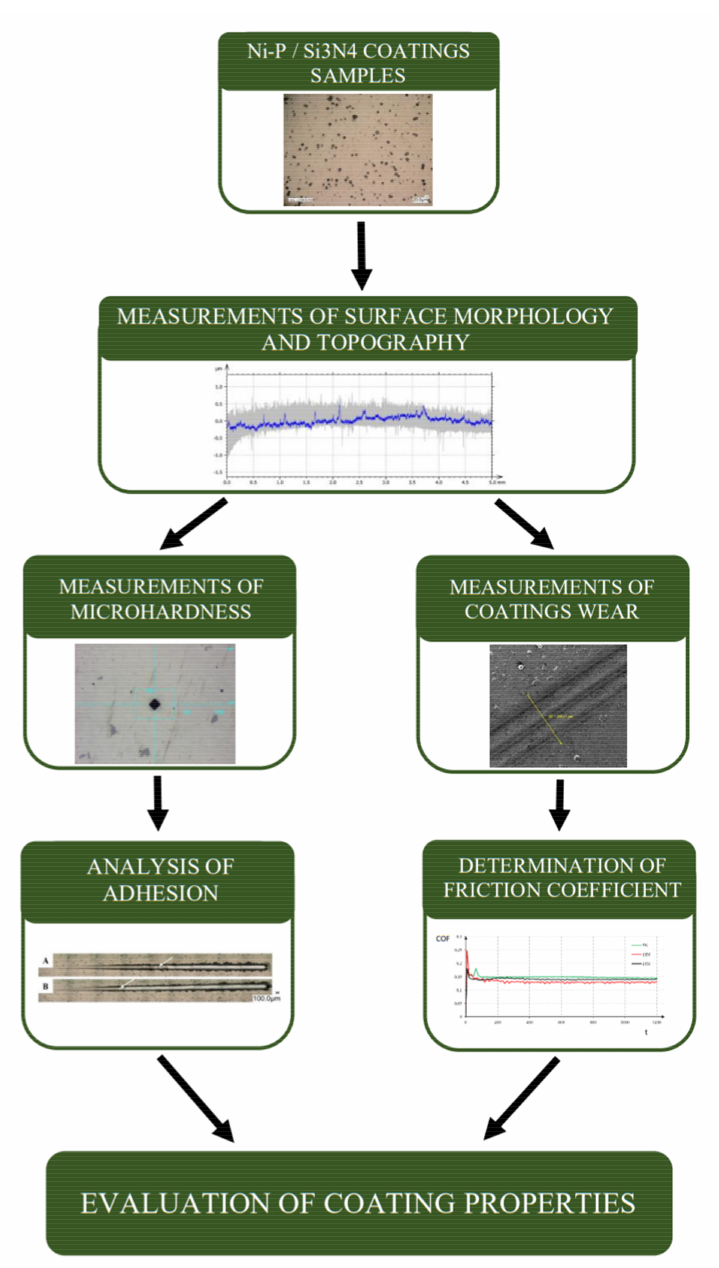
Figure 1. The scheme of a conducted experiment. The samples were degreased in acetone, etched in an alkaline solution (0.75% NaOH) (CHEMPUT, Piekary ´Sl ˛askie, Poland) and galvanized in a multi-component solution; the composition and concentrations are given in Table